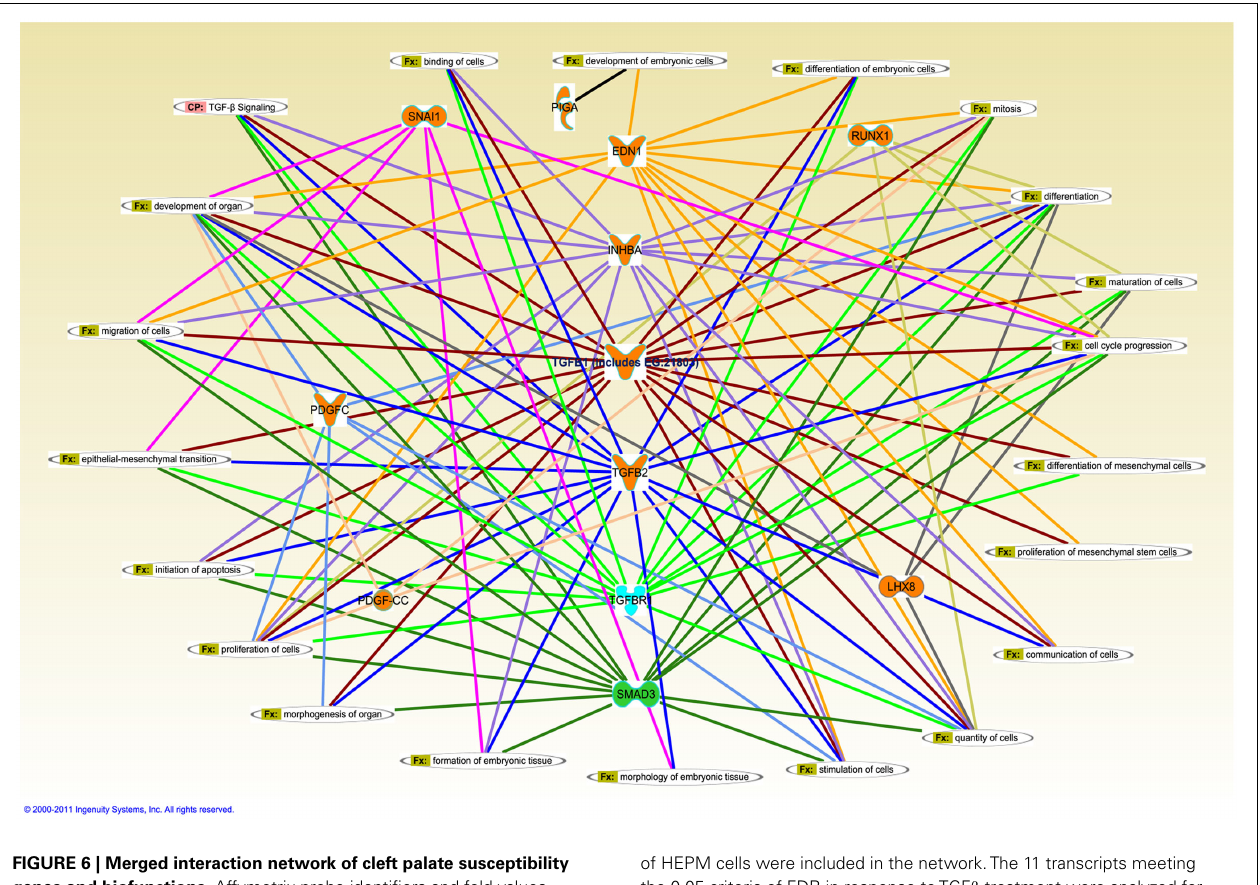
FIGURE 6 | Merged interaction network of cleft palate susceptibility genes and biofunctions. Affymetrix probe identifiers and fold-values were uploaded to IPA and each identifier was mapped to its corresponding gene object in the IKB. Interactions were then queried between these gene objects and all other gene objects stored within IPA to generate a set of direct interaction networks that were merged. Cellular functions that directly interact with differentially expressed putative candidate genes for cleft palate in response toTGF β treatment